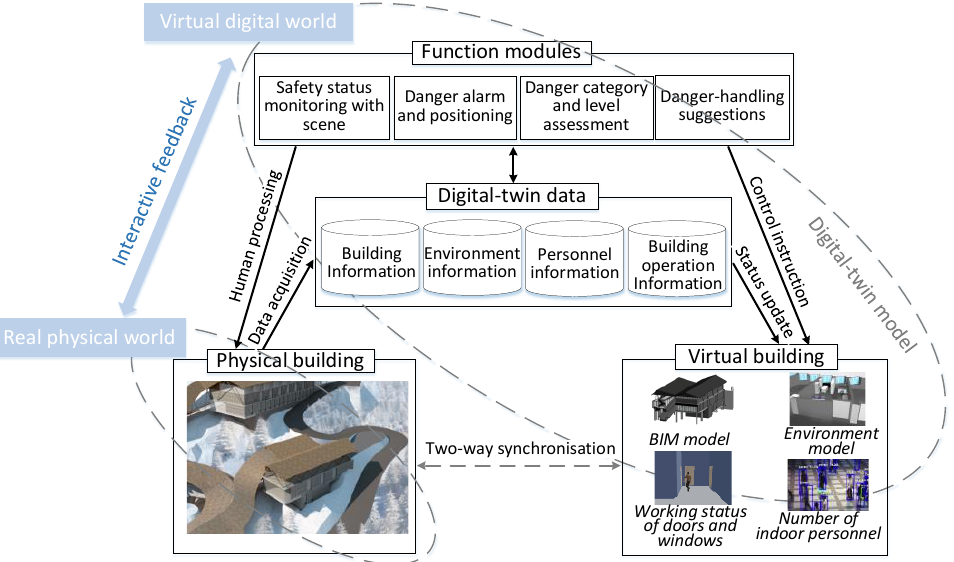
Figure 1. Concept of an indoor safety management system integrating with the digital twin model.